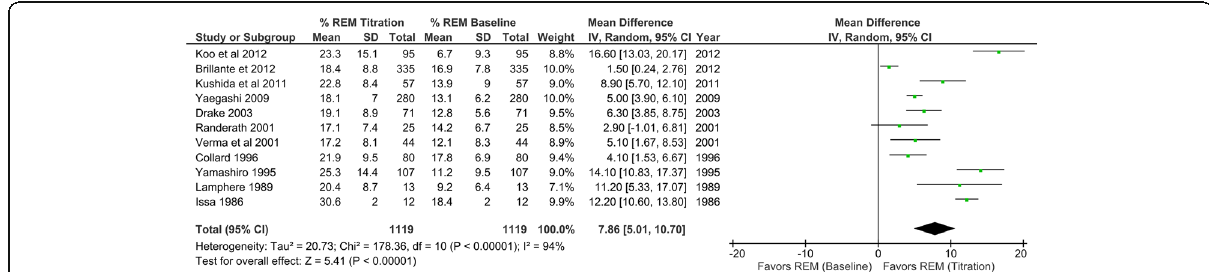
Fig. 3 Pre- and post-nasal CPAP REM Rebound (percent of REM sleep duration percentage) mean difference. (SD, standard deviation; CI, confidence interval; REM, rapid eye movement